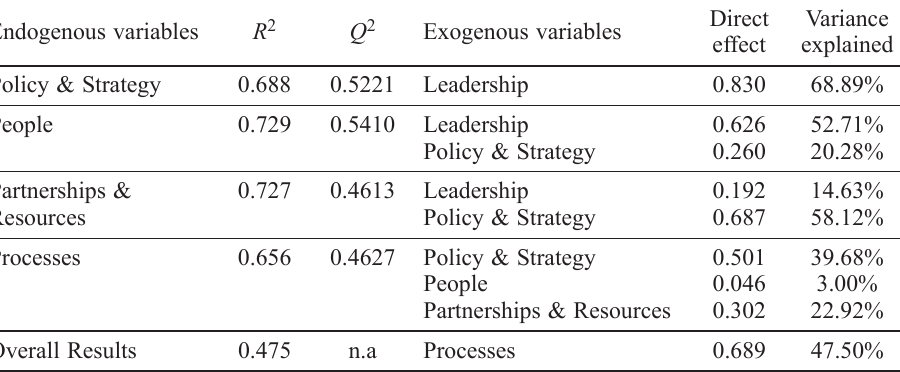
Table 5. Effects on endogenous